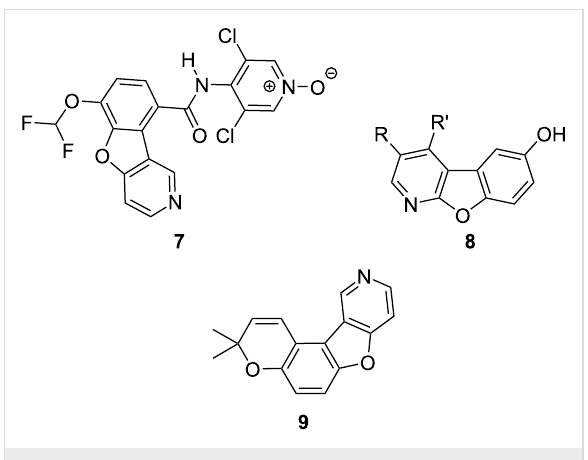
Figure 2: Representative bioactive structures containing benzofuro- fused pyridine analogues 7 – 9